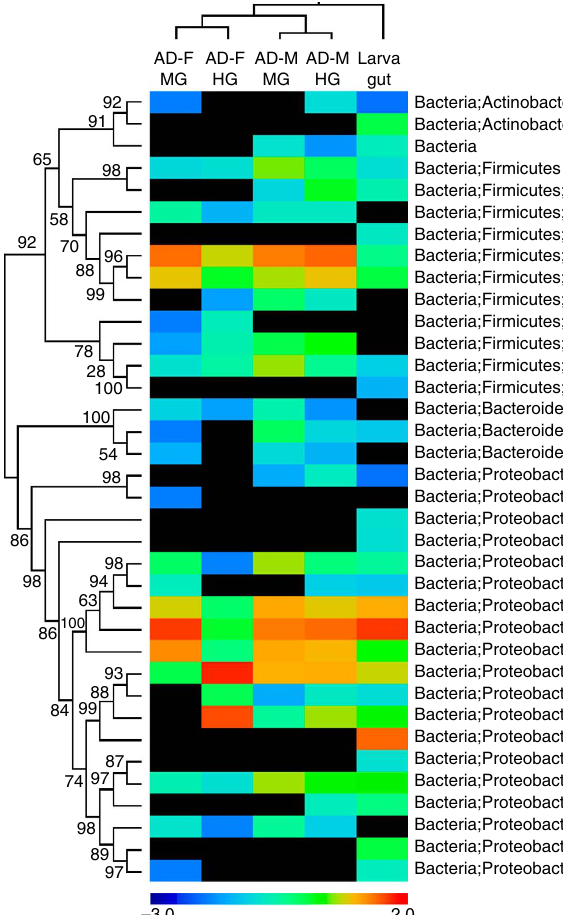
Figure 3 | Bacterial community composition of the N. vespilloides gut. Composition of the bacterial community in the gut of N. vespilloides larvae and the midgut and hindgut of adult males and females was studied by TEFAP analysis of 16 S rRNA gene sequences. The heat map shows the abundance of bacterial taxa (log-transformed), with warm colours indicating high abundance, cold colours indicating low abundance and black denoting absence. Taxonomy was assigned to representative sequences using the RDP classifier implemented in QIIME, and the phylogeny was generated in FastTree, based on an alignment produced using SINA and ARB. The samples were clustered based on the unweighted UniFrac distances of microbial community profiles (AD, adult; M, male; F, female; MG, midgut; HG,